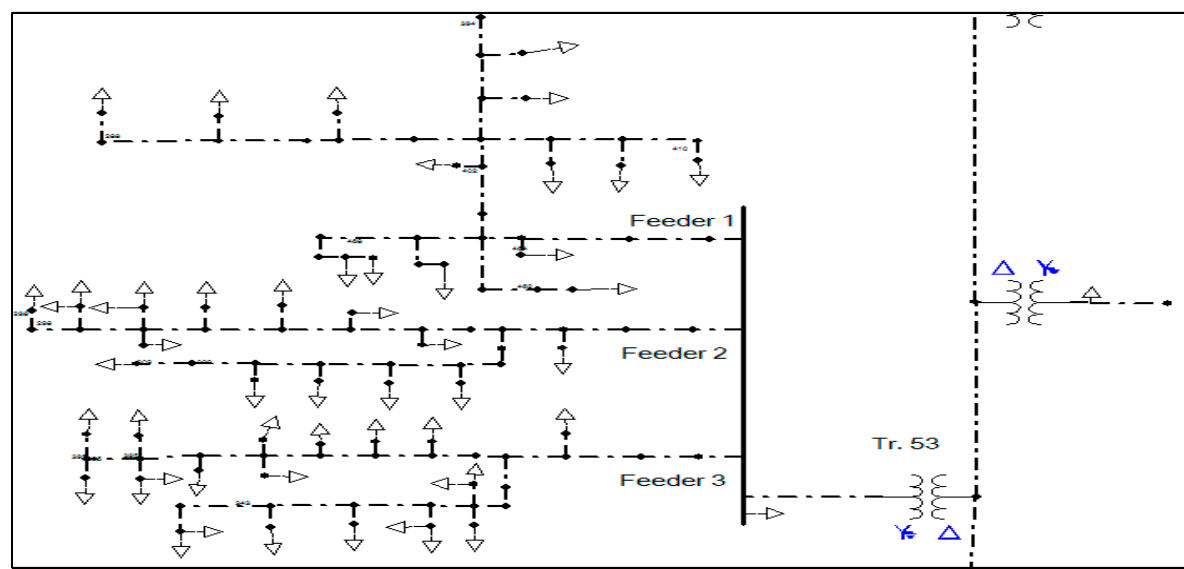
Figure 10. LV network of transformer No. 740.